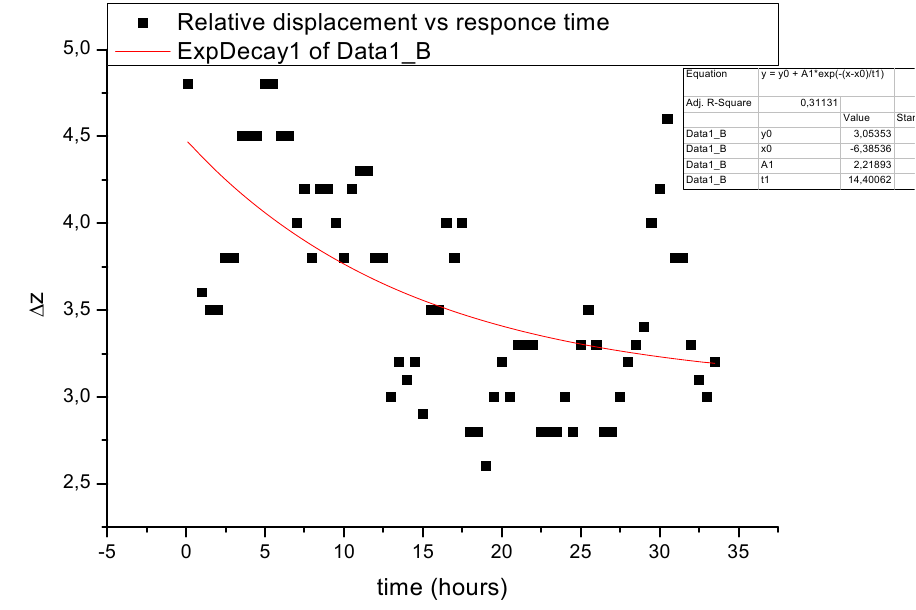
Figure 6. Relative displacement of samples in Phases 3 and 4 following an abrupt change in RH as a function of time. Relative displacement remains high even in shorter